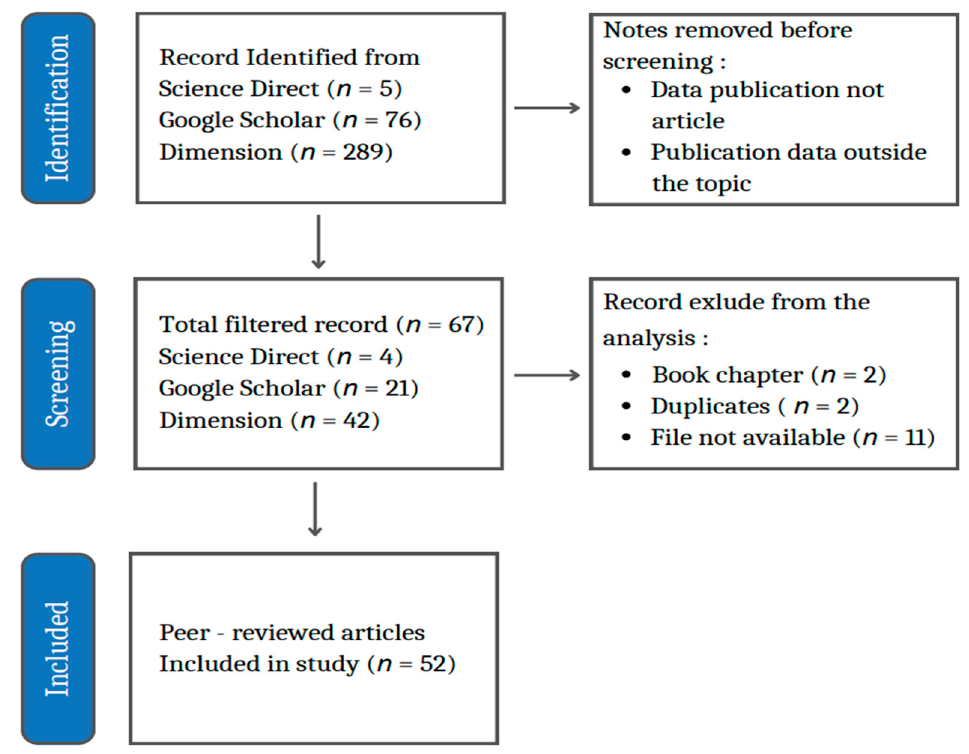
Figure 1. Flowchart of the search strategy. Table 1. Number of publications from three databases with three types of keywords.